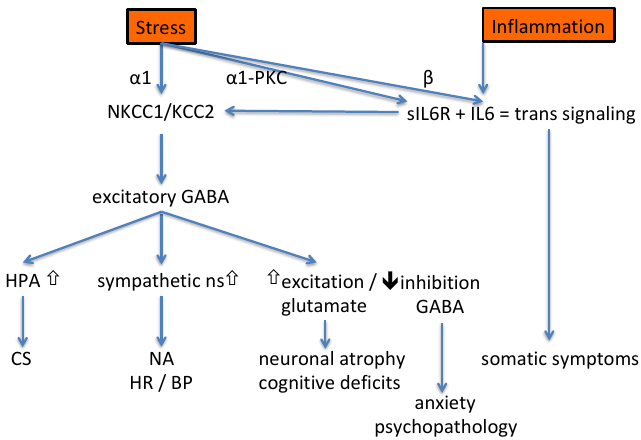
Figure 3. A graphical summary of the biological effects induced by stress and inflammation. As reviewed in Sections 2 and 3 of this manuscript, inflammation and psychological stress activate the hypothalamic-pituitary-adrenal (HPA) axis, the sympathetic nervous system, and increase glutamate, while the inhibitory e ff ect of gamma-aminobutyric acid (GABA) is diminished. This leads to measurable increases in circulating corticosteroids, catecholamines, anxiety, somatic and psychopathological symptoms, and a decline in cognitive functions. Both stress and inflammation a ff ect the function of the chloride transporters, Na-K-Cl-cotransporter-1 (NKCC1) and K-Cl-cotransporter-2 (KCC2), and provoke IL-6 trans-signaling. Although there is a large qualitative overlap, it may be that stress and inflammation lead to quantitative di ff erences in the severity of the individual e ff ects. Legend: BP = blood pressure, CS = corticosterone, HR = heart rate, NA = noradrenaline, ns = nervous system, PKC = protein kinase C, sIL6R = soluble IL6